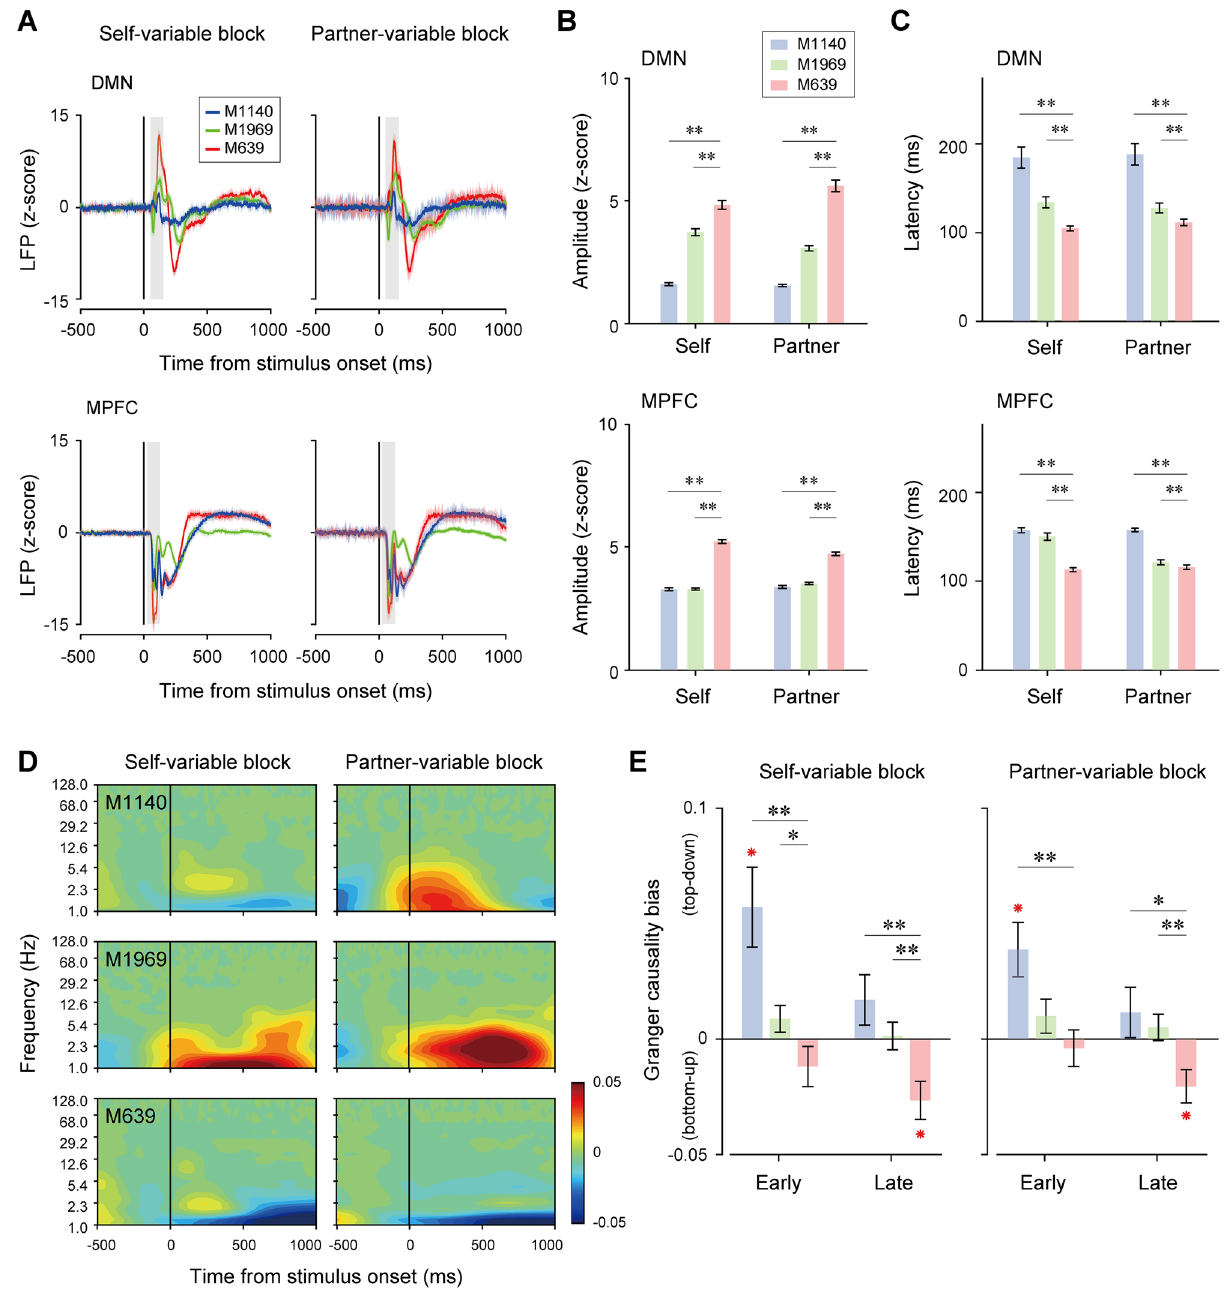
Figure 5. Neural activity properties in M639. ( A ) Responses of LFPs to conditioned stimuli. Gray rectangles indicate early LFP components. ( B ) Rectified amplitude of early LFP components. Mean ± SEM. Self, self- variable block. Partner, partner-variable block. ** P < 0.01, two-tailed Welch’s t -test. ( C ) Latency of early LFP components. Same conventions as in ( B ). ( D ) Coherence between MPFC and DMN. ( E ) Causal information flow bias. Values indicate the proportion of channel pairs with significant Granger causality from the MPFC to DMN (top-down direction) minus the proportion of channel pairs with significant Granger causality from the DMN to MPFC (bottom-up direction). * P < 0.05, ** P < 0.01, two-tailed Welch’s t -test. Red stars indicate a significant difference from zero ( P < 0.01, two-tailed Wilcoxon signed-rank test). Other conventions are the same as in ( B